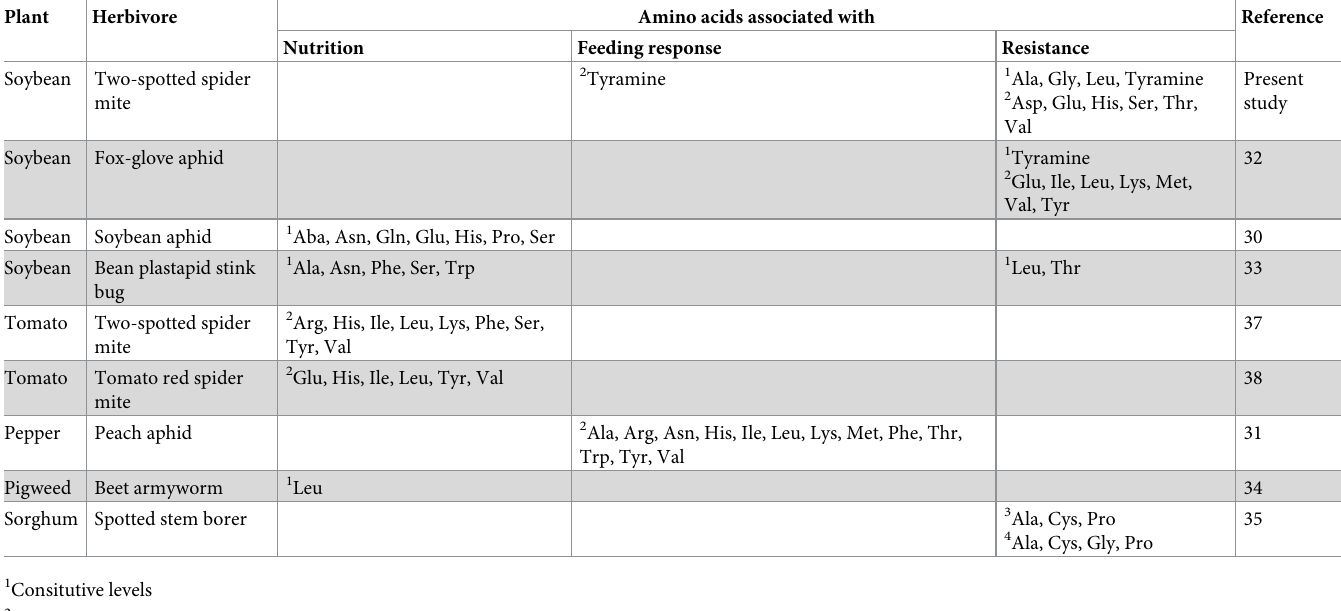
Table 6. Amino acids associated with herbivore nutrition, feeding response or plant resistance.